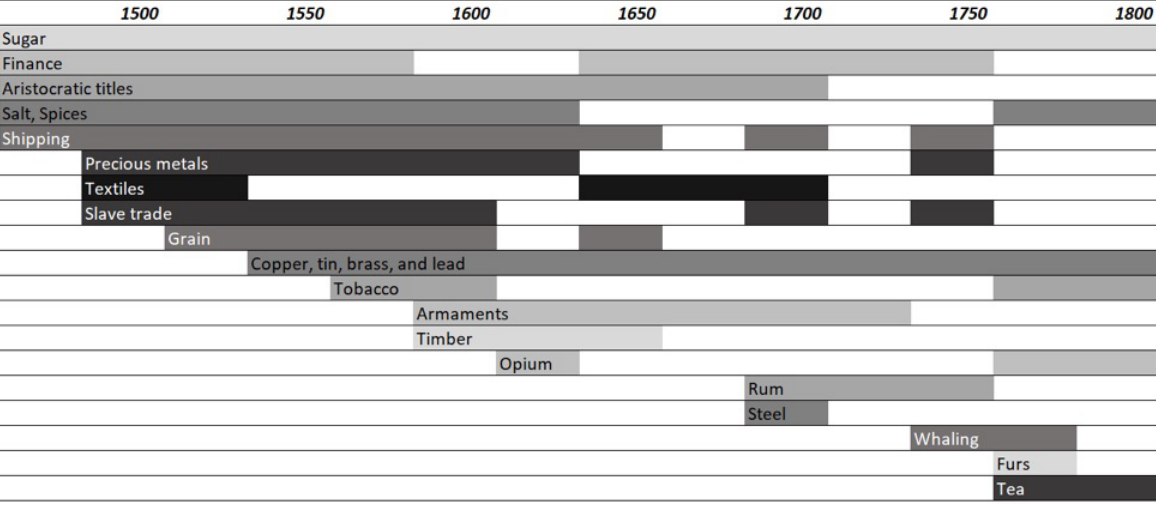
Figure 1: Stylized timeline of wealth-generating activities of World-Magnates, 1500-1800